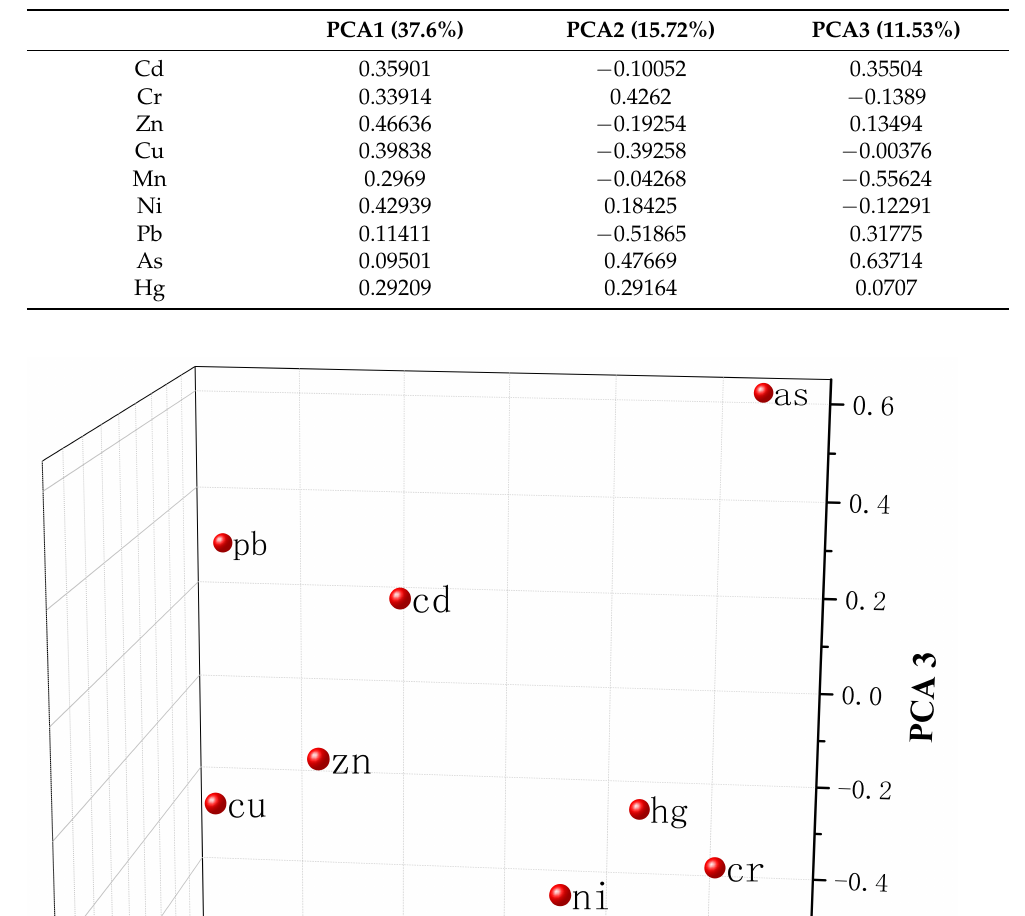
Table 2. Load values of heavy metals from principal component analysis of Shaanxi Province soil samples.